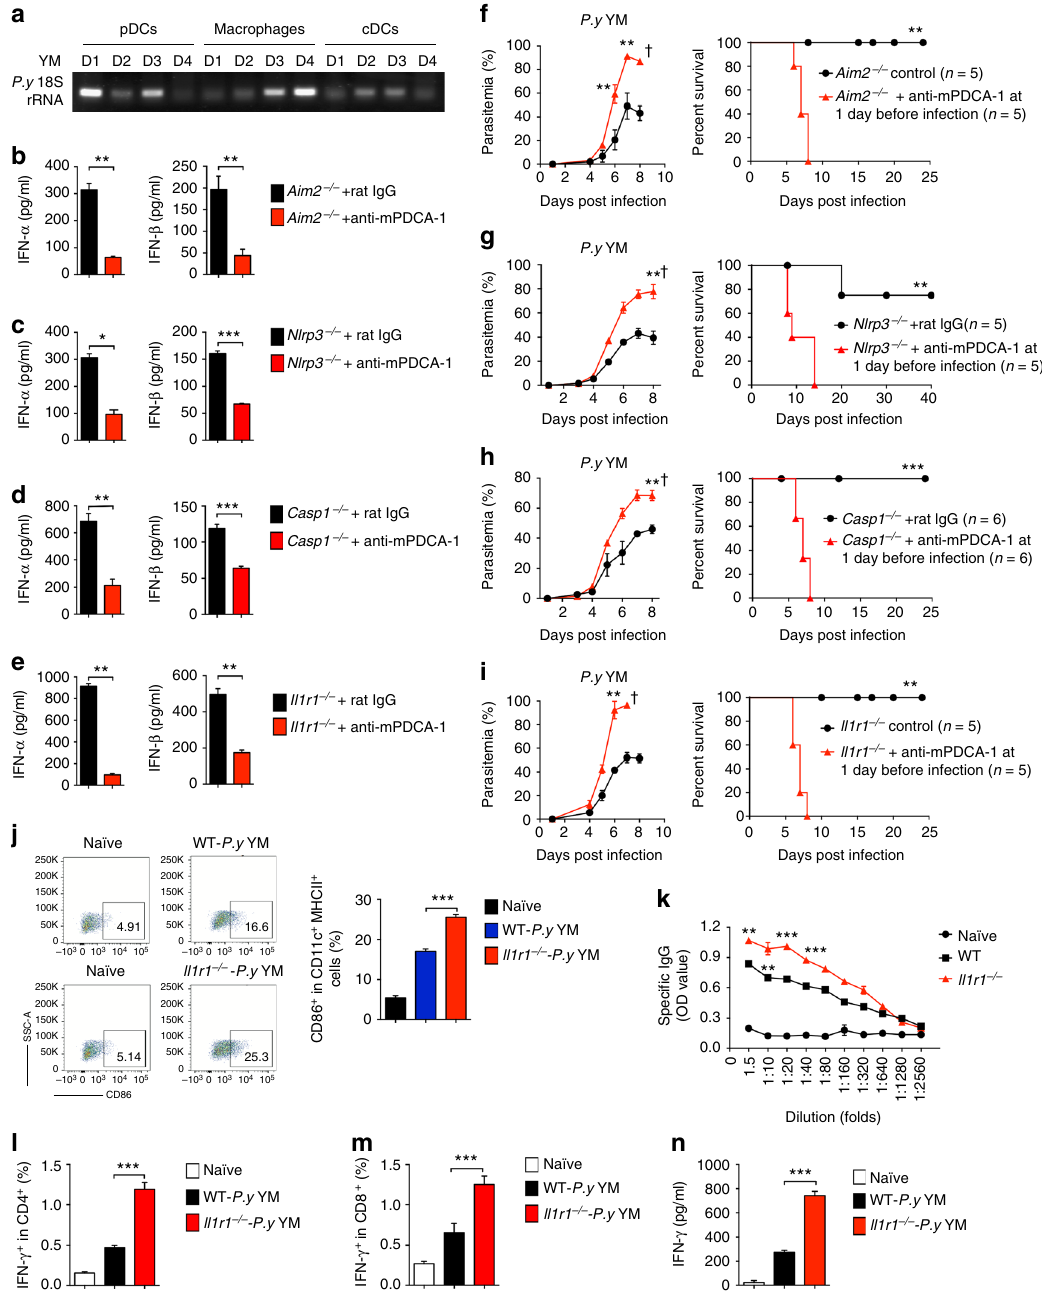
Fig. 5 pDCs contribute to the production of type I IFN at the early time post P. yoelii YM infection and ameliorate pathogenesis in in fl ammasome-de fi cient mice. a The cell populations of pDCs, cDCs, and macrophages were isolated from WT mice splenocytes at indicated times post YM infection using cell isolation kits, and then analyzed for cell-speci fi c expression of P. yoelii 18 S rRNA by PCR. b – e Aim2 − / − ( b ), Nlrp3 − / − ( c ), Casp1 − / − ( d ), and Il1r1 − / − ( e ) mice ( n = 5) were injected with anti-mPDCA-1 antibody at 12 h before and after infection, followed by P. yoelii YM infection. Serum was collected at 24 h post infection and subjected to ELISA analysis for IFN- α and IFN- β . f – i Aim2 − / − ( f ), Nlrp3 − / − ( g ), Casp1 − / − ( h ), and Il1r1 − / − ( i ) mice ( n = 5) were injected with anti-mPDCA-1 antibody at 12 h before and after infection, followed by P. yoelii YM infection. Parasitemias and survivals were monitored daily. j WT and Il1r1 − / − mice ( n = 5) were infected with YM. Splenocytes were collected at day 4 post infection, and CD86 + cells in CD11c + MHC-II + cells were measured by fl ow cytometry. Representative FACS and statistical analysis of CD86-positive cells are shown. k Malaria speci fi c IgG in serum from WT and Il1r1 − / − mice ( n = 5) at day 14 post YM infection, evaluated using